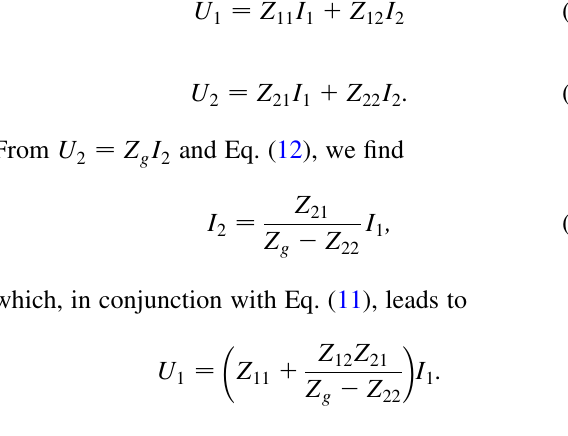
and L denote 1 2